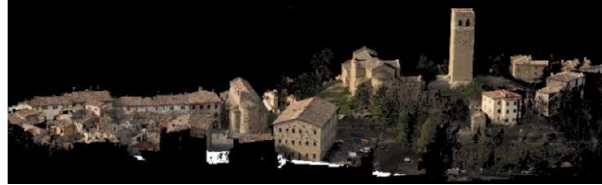
Figure 10. True coloured point cloud of the urban centre.